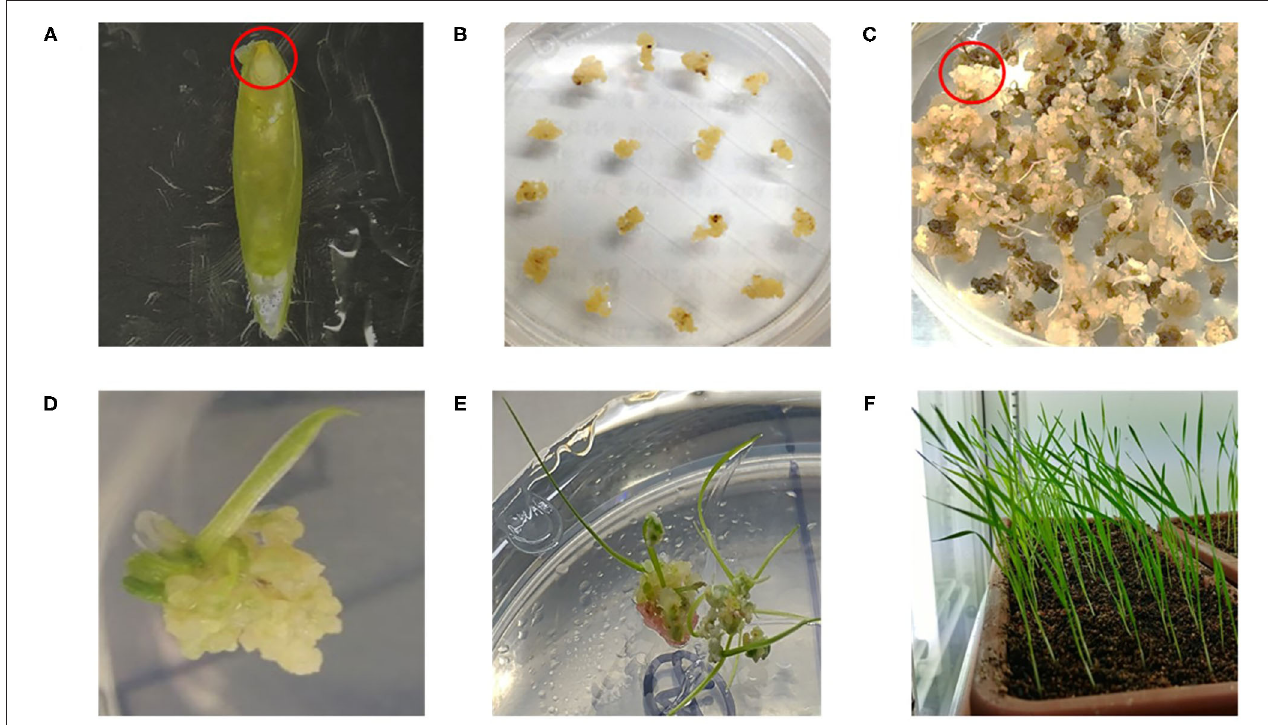
FIGURE 2 | Preparation of seed-specific AtCYP85A2- expressing transgenic Brachypodium . (A) Region of embryonic cells (red circle) dissecting from immature seed of Bd21-3, the wild type Brachypodium. (B) Calli induced from embryonic cells in callus induction media (CIM). (C) Hygromycin resistant yellowish-brown calli after agrobacterium-mediated transformation. Red circle indicates the selected calli. (D) Regenerated shoot from AtCYP85A2 -expressing callus in regeneration medium (ReM) for 7 days. (E) Regenerated shoot and root from AtCYP85A2 -expressing callus in ReM for 21 days. (F) AtCYP85A2 -expressing transgenic Brachypodium plants.